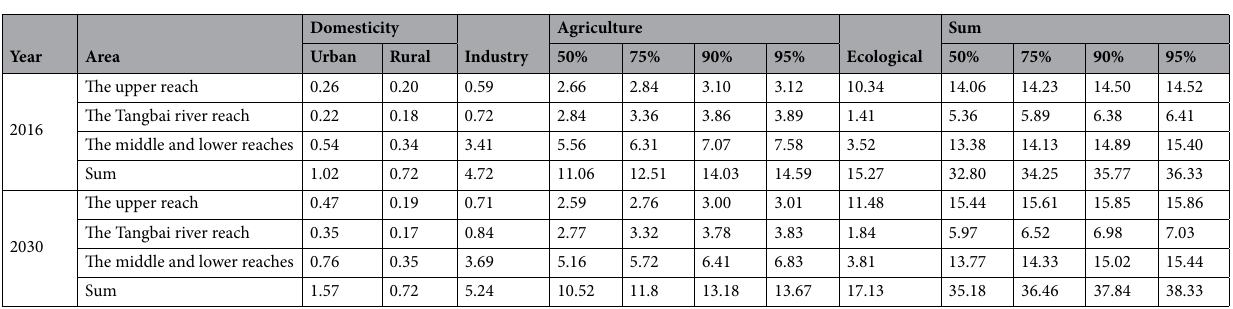
Table 7. Water demand projection of the Han River basin in 2016 base year and 2030 planning year (billion m 3 ).